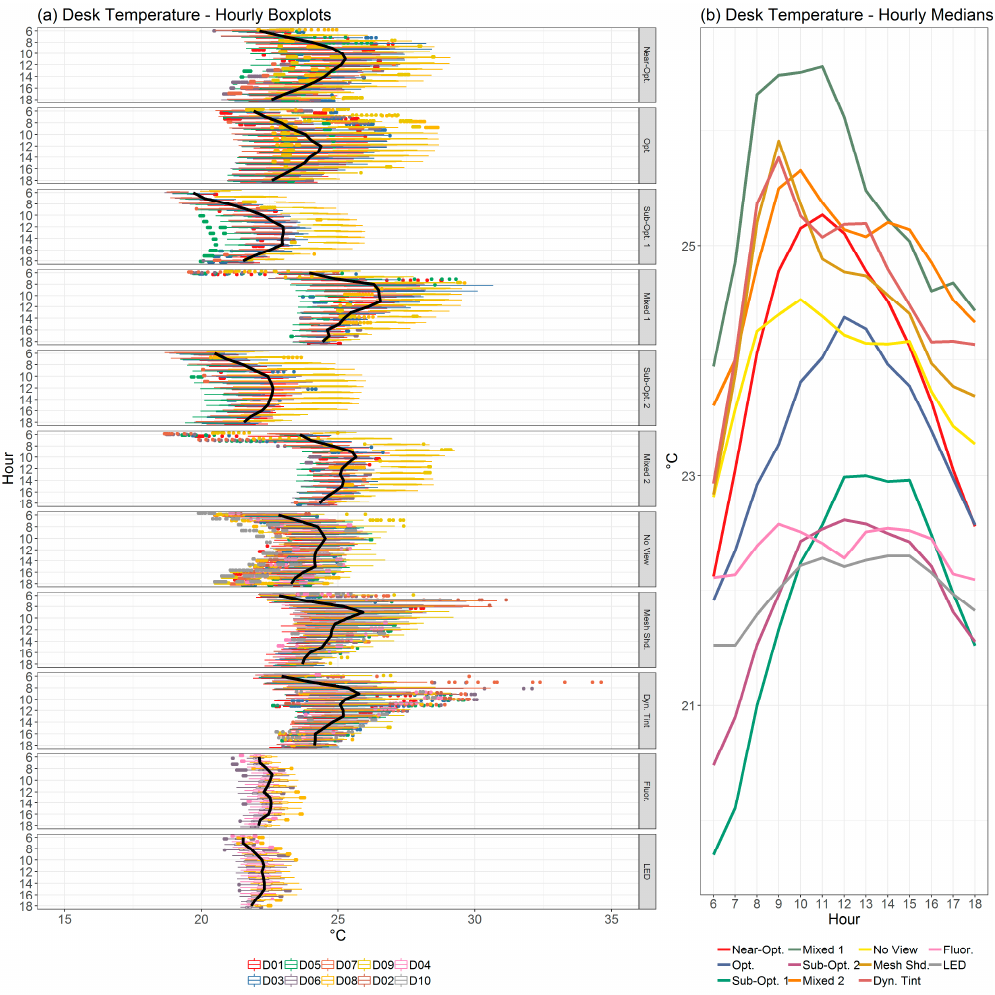
Figure 3. ( a ) Hourly boxplots plots by sensor with cross-sensor hourly medians as red lines and 487 ( b ) hourly medians of desk temperatures by experimental condition during three office experiments. 488